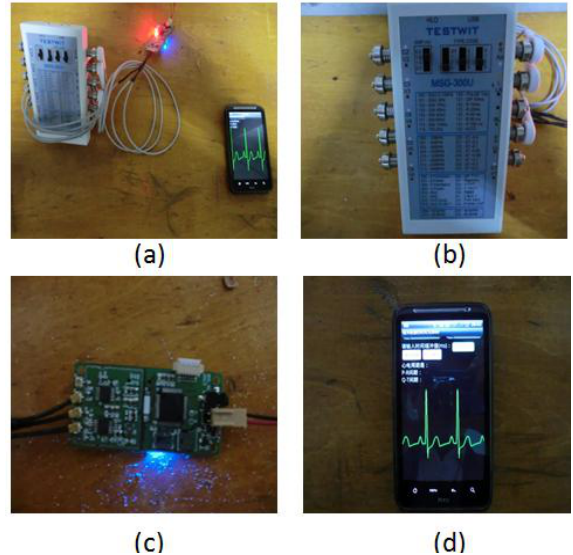
Figure 13. ECG signal classification